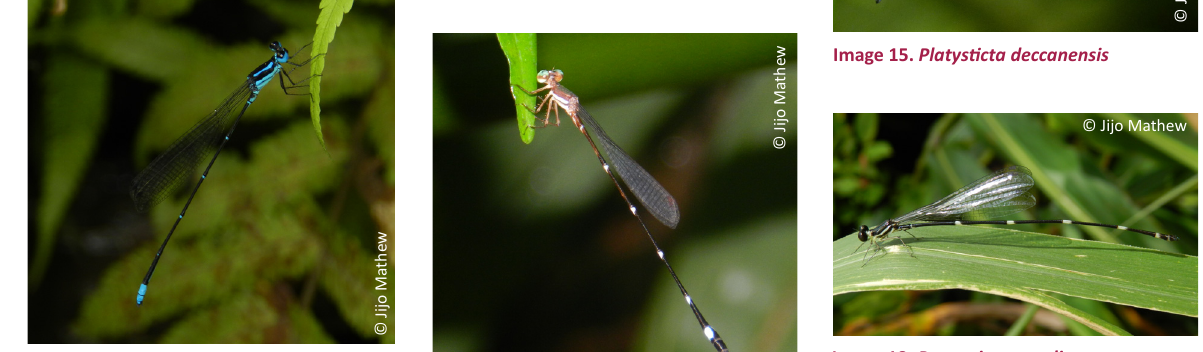
Image 18. Protosticta gaveli